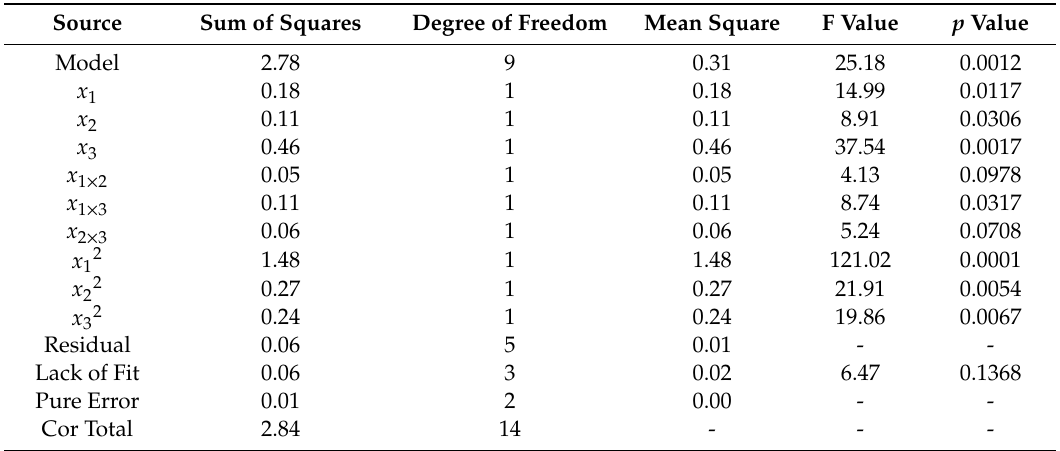
Table 4. Analysis of variance (ANOVA) for the regression model of hydrogen production rate.